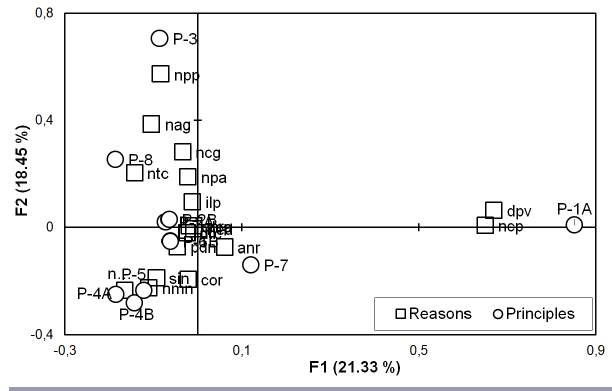
Fig. 3. Redundancy analysis biplot of the reasons for prioritizing each of the design principles, obtained through focus groups in Tumaco. The x-axis (F1) accounts for 22.0% of the variance, and the y-axis (F2) accounts for 17.1%. See Tables 1 and 5 for